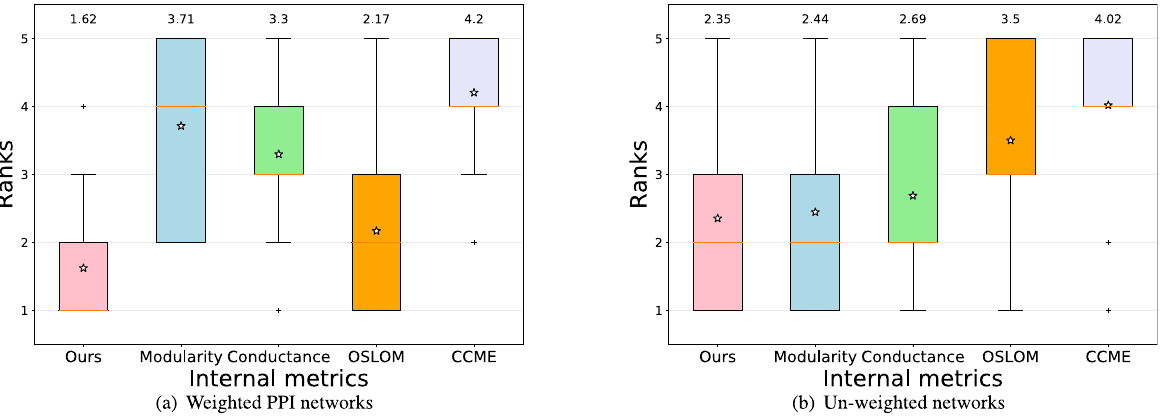
Figure 3. The rank distribution for each internal validation metric on ( a ) weighted PPI networks and ( b ) Un-weighted networks. Here the box plot is used to depict the distributions: minimum (lower line), lower quartile (lower edge of the box), median (center line), upper quartile (upper edge of the box) and maximum (upper line). Meanwhile, mean (star) and outlier (cross) are also plotted.